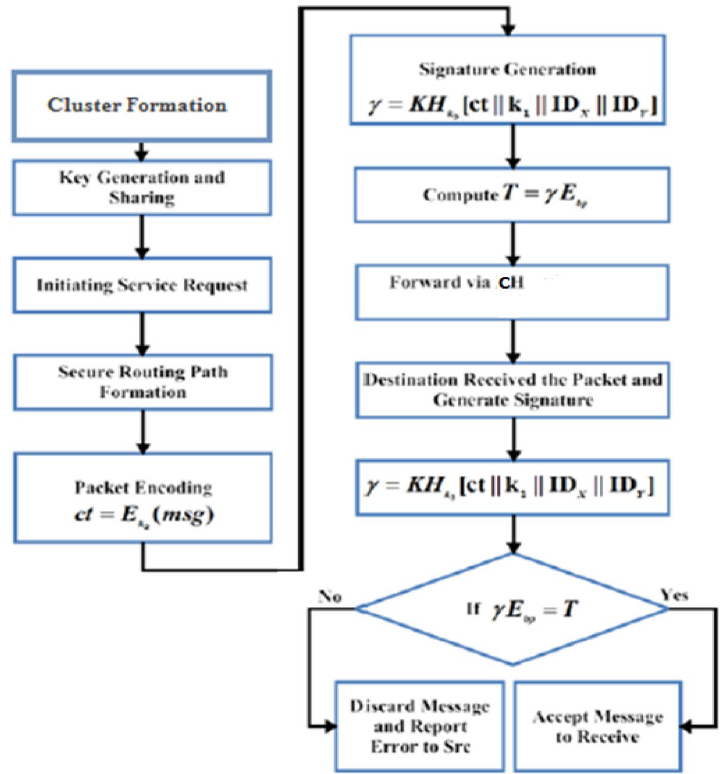
Fig. 6 Flow diagram for the proposed